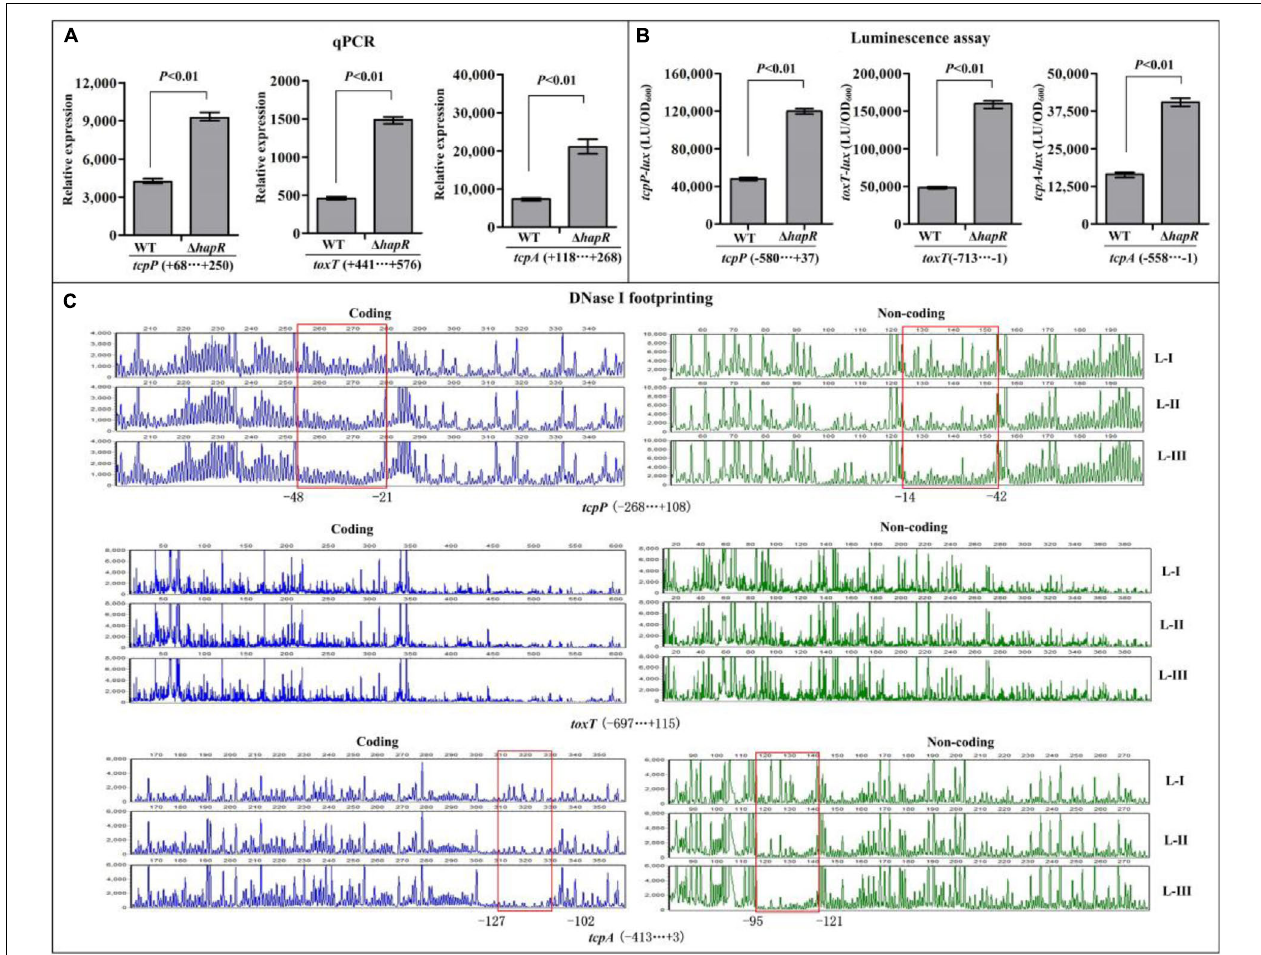
FIGURE 3 | Regulation of tcpP , toxT , and tcpA by HapR. (A) qPCR. Relative mRNA levels of the target genes were compared between (cid:49) hapR and WT. (B) The luminescence assay was done as shown in Figure 2 . (C) DNase I footprinting. The promoter DNA fragment of each target gene was labeled with FAM and HEX, respectively, and incubated with increasing amounts of purified His-HapR (L-I, -II, and -III contain 0, 2.31, and 6.92 pmol, respectively). After being digested with DNase I, the fragments were analyzed using an ABI 3500XL DNA analyzer. The protected regions are boxed and marked with positions. The negative and positive numbers indicate the nucleotide positions relative to the translation start site (+1) of the corresponding